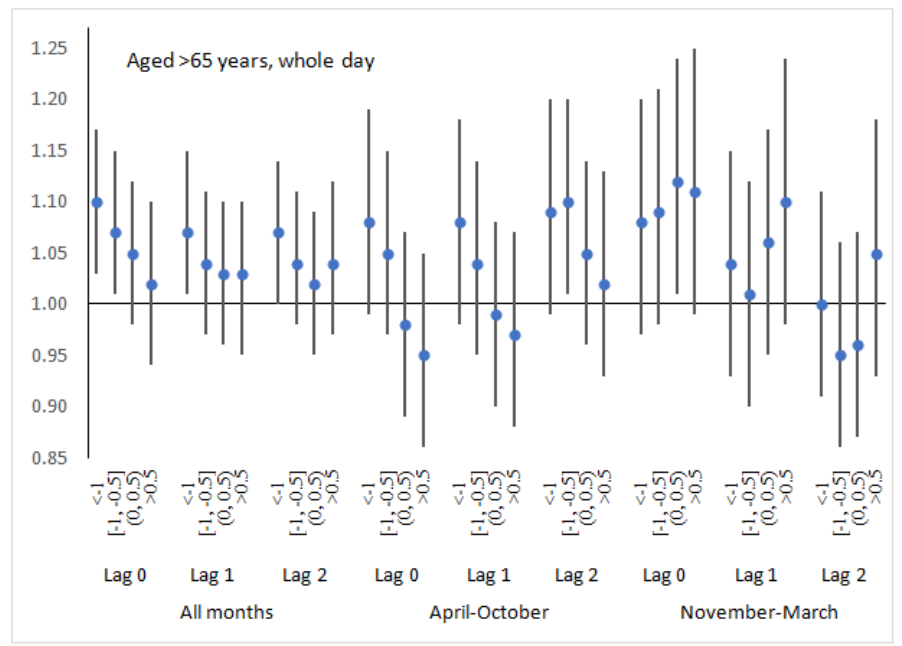
Figure 2. Rate ratios of emergency ambulance calls for elevated arterial blood pressure in the categories of the NAO index (reference category the NAO index between − 0.5 and 0), adjusting for years, month, the day of the week, day length, weather and space weather variables. Table 1. Significant associations between the NAO index and daily emergency calls for elevated arterial blood pressure in rate ratios (RR), adjusting for day length, month, years, the day of the week, space weather variable, weather variables and exposure to CO, PM 10 and ozone.